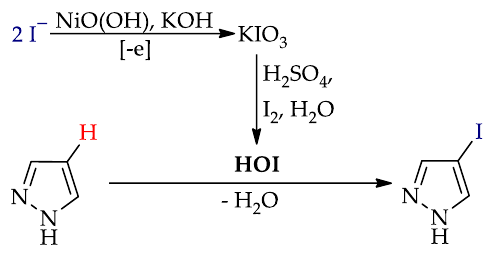
Scheme 8. C – H iodination of pyrazoles via HOI.